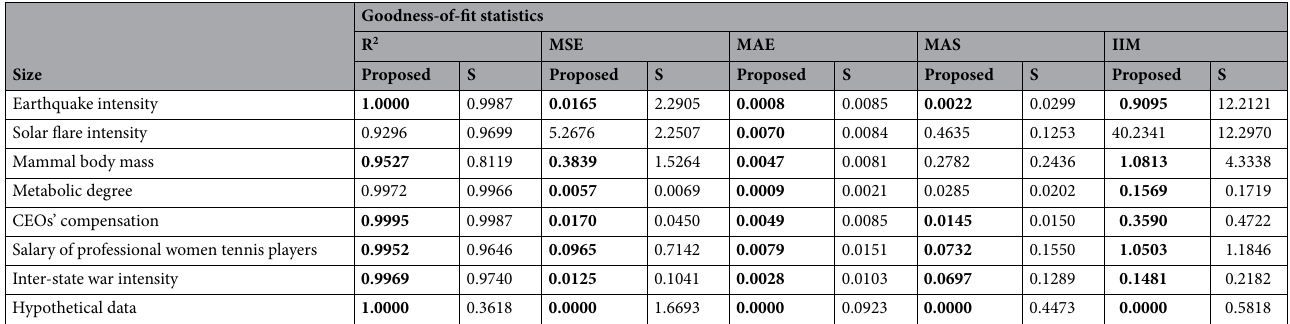
Table 5. The evaluation of performance of the proposed model and that of the S model based on five goodness-of-fit statistics. The bold numbers indicate that the proposed model is superior to the S